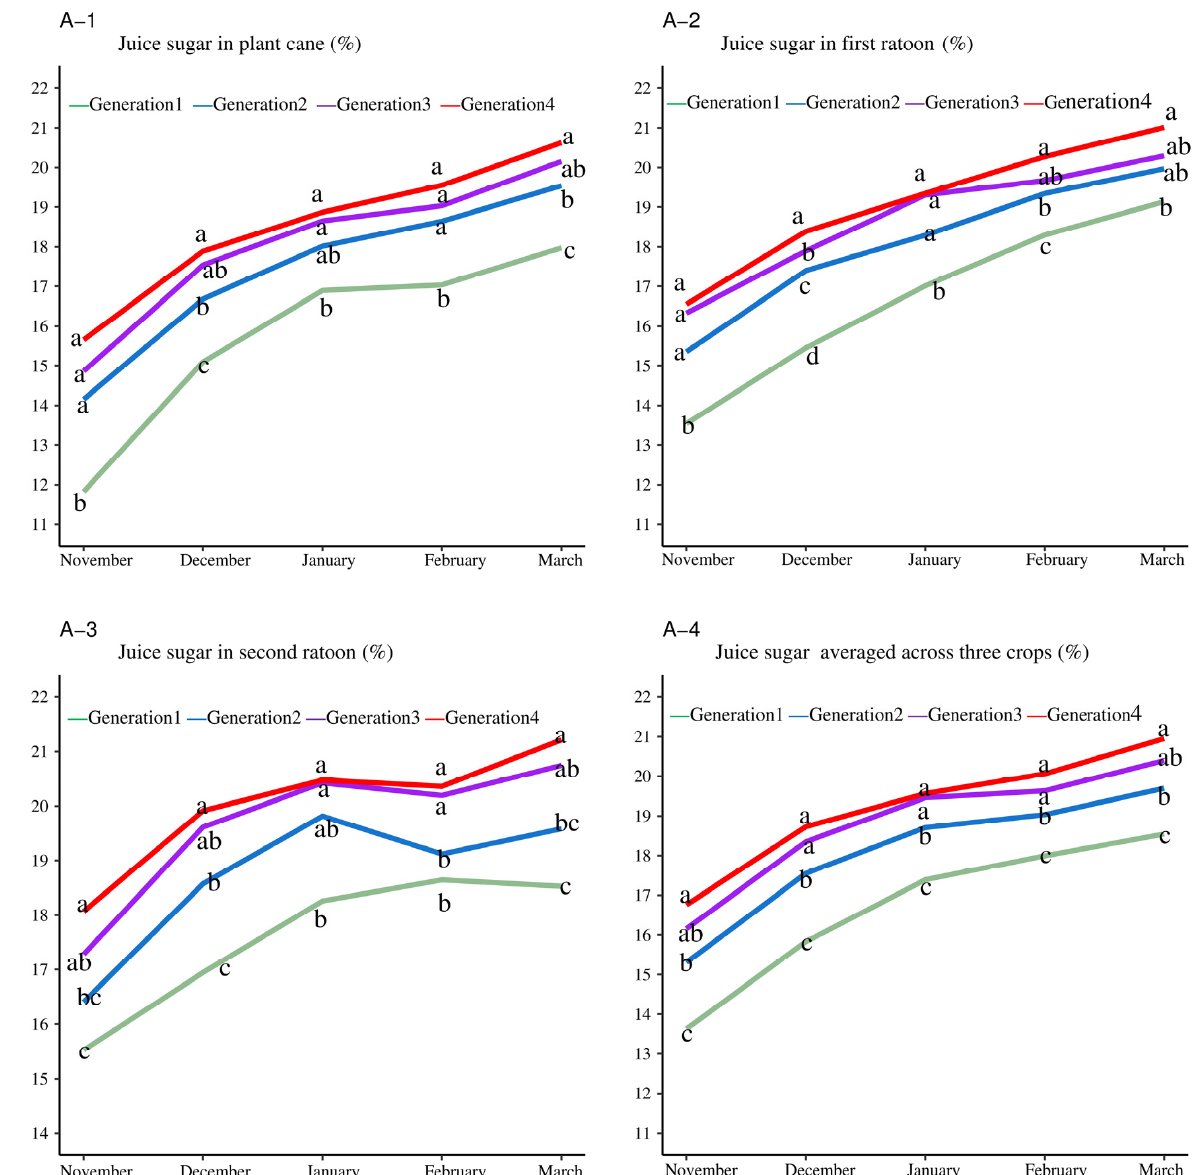
Figure 1. Analysis of the improvement in the sugar content of juice in four generations of sugarcane varieties in China. Monthly differences (November to March) of the four generations of planted cane ( A-1 ), the first ratoon ( A-2 ), the second ratoon ( A-3 ), and the average content across three crops ( A-4 ). a, b, c, d, p < 0.05, determined by the LSD test; the LSD test was across generations within a month.